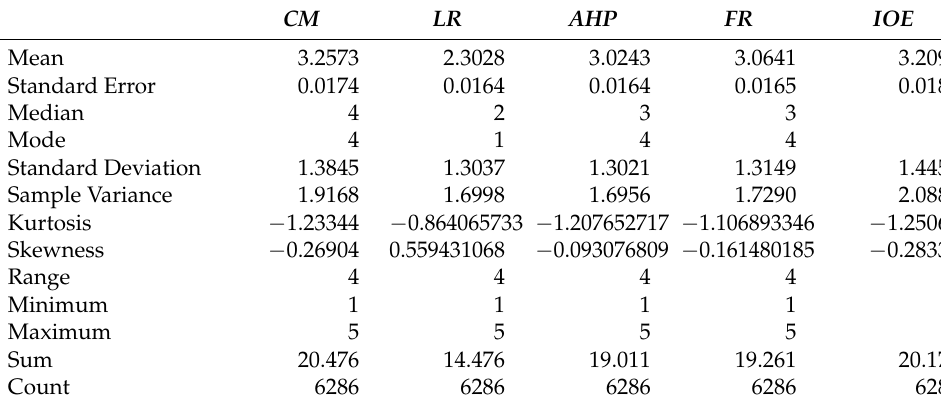
Table 9. Basic statistics of outputs covering whole study